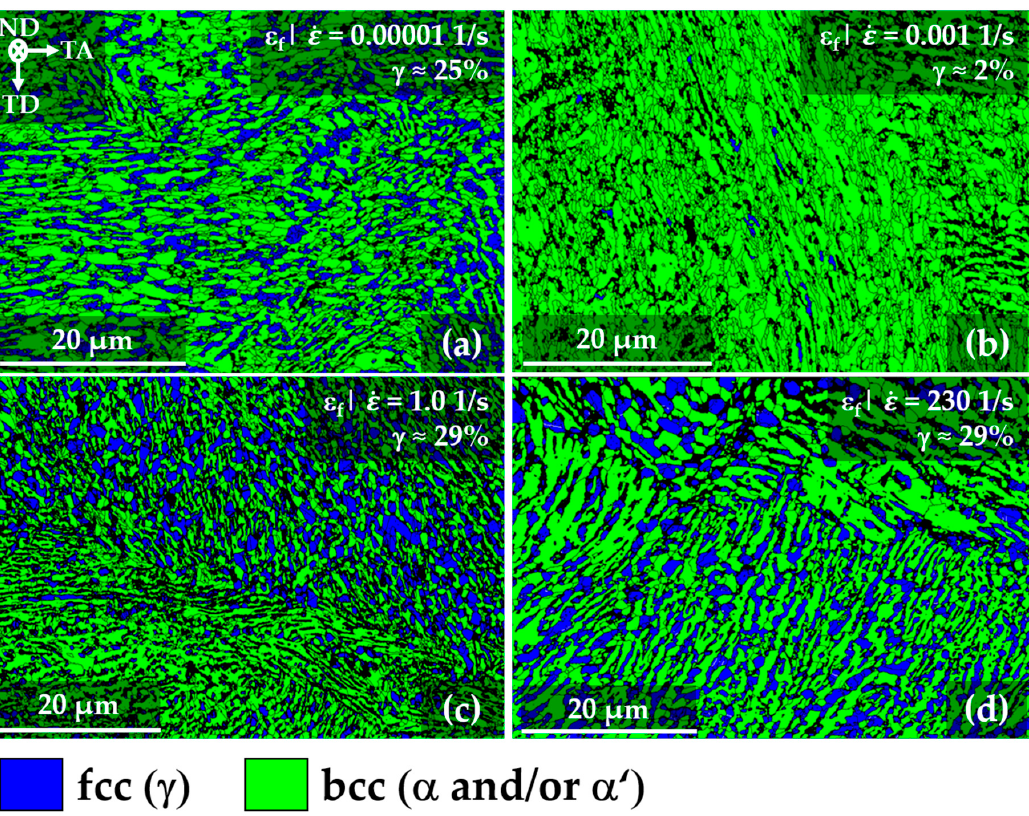
Figure 5. γ phase fractions (blue) as determined by EBSD measurements after tensile testing to fracture at ( a ) 0.00001 1/s, ( b ) 0.001 1/s, ( c ) 1.0 1/s, and ( d ) 230 1/s. Green areas indicate a body-centered cubic crystal structure, α and/or α ’.